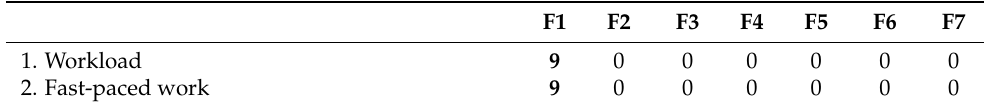
Table A1. Psychosocial risk factors: target matrix for the first